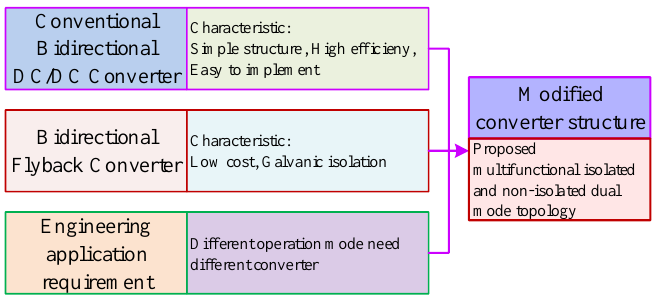
Figure 2. The design methodology of proposed new converter.